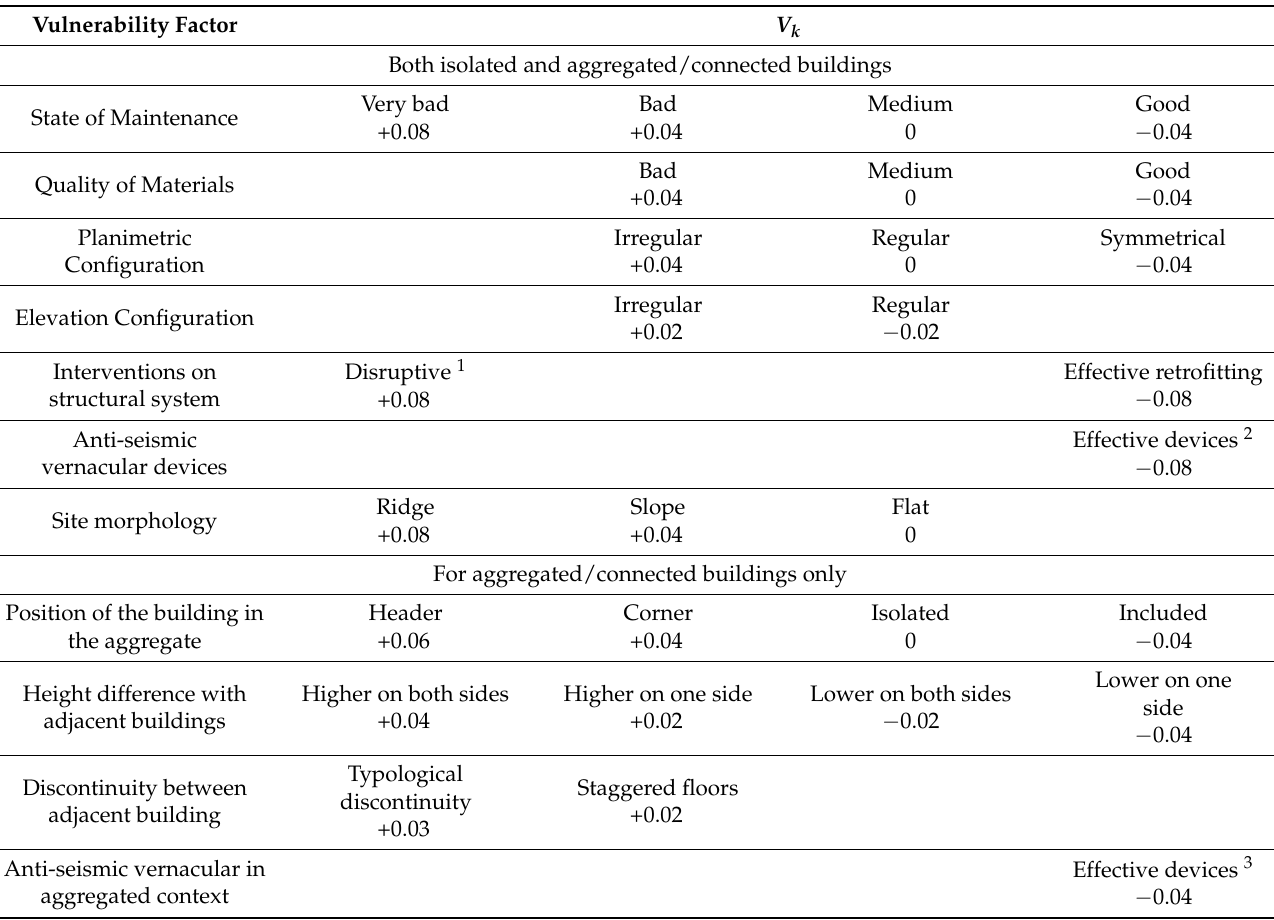
Table 4. Values of vulnerability index modifiers V k to be applied at both single and aggregated buildings and V k peculiar for aggregated building